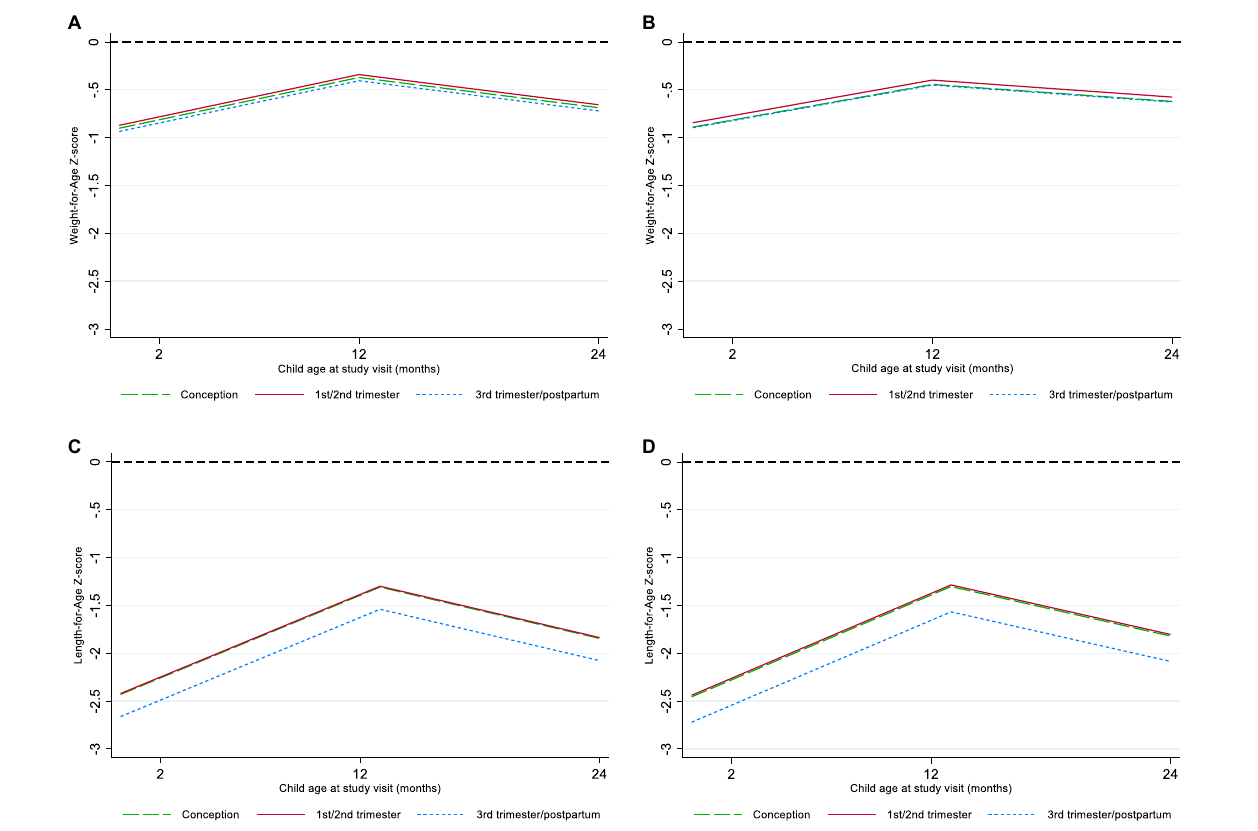
FIGURE 3 | Marginal plots of Weight-for-Age and Length-for-Age by timing of antiretroviral therapy exposure. (A) Crude Weight-for-Age, (B) confounder-adjusted Weight-for-Age, (C) crude Length-for-Age, (D) confounder-adjusted